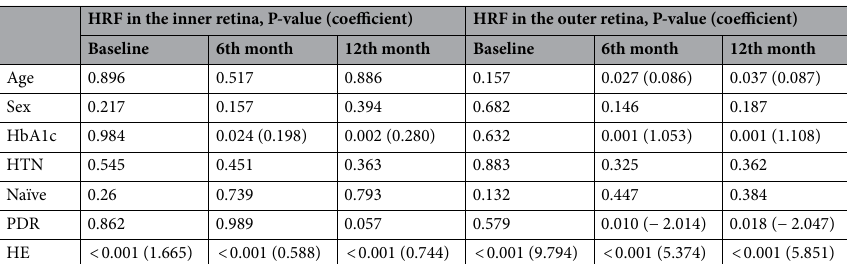
HRF in the inner retina, P-value (coefficient) HRF in the outer retina, P-value (coefficient) Baseline 6th